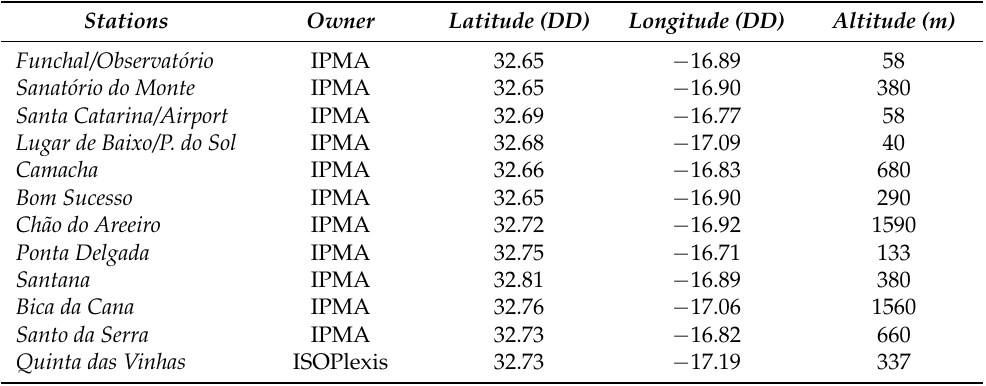
Table 1. Meteorological stations were used to assess and model climatic conditions in the Madeira and Quinta das Vinhas case